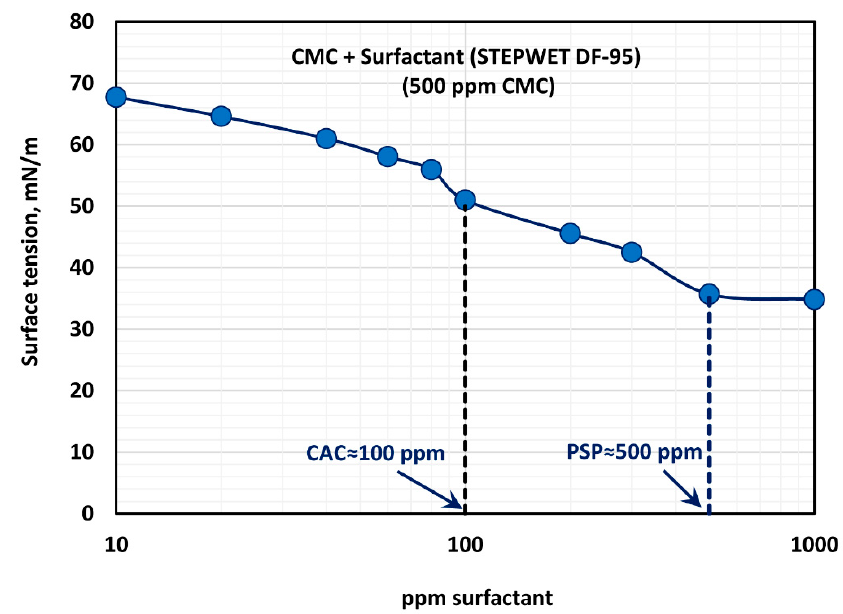
Figure 7. Variation of surface tension of surfactant-polymer solutions with the increase in surfactant concentration, at a fixed polymer concentration of 500 ppm.